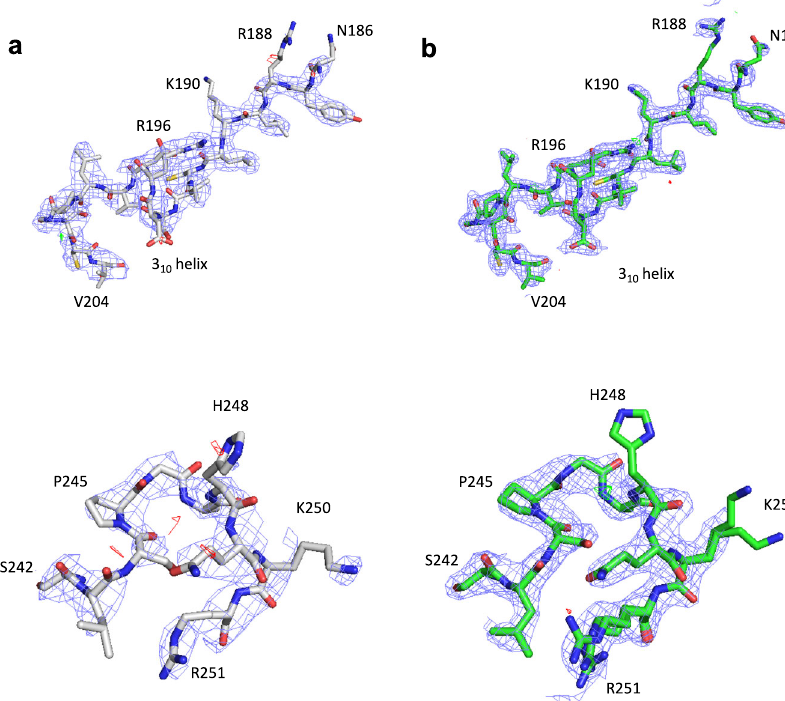
Fig. 4 Structure determination and model building of the MyD88 TIR higher-order assembly by MicroED and SFX. Models and maps are presented of the remodelled BB loop (residues 186 – 204; top) and CD loop (residues 242 – 251; bottom) for the a MicroED and b SFX a structures. The carbon atoms in the MicroED and SFX a structures are shown in grey and green, respectively. Nitrogen, oxygen and sulfur atoms are shown in blue, red and yellow, respectively. The electrostatic scattering potential (MicroED) and electron density (SFX) 2mFo − DFc maps (blue isomesh) are contoured at 1.2 σ , and the difference mFo − DFc maps (green and red isomesh for positive and negative density, respectively) are contoured at 2.8 σ . No missing re fl ections were restored using weighted Fc values for map